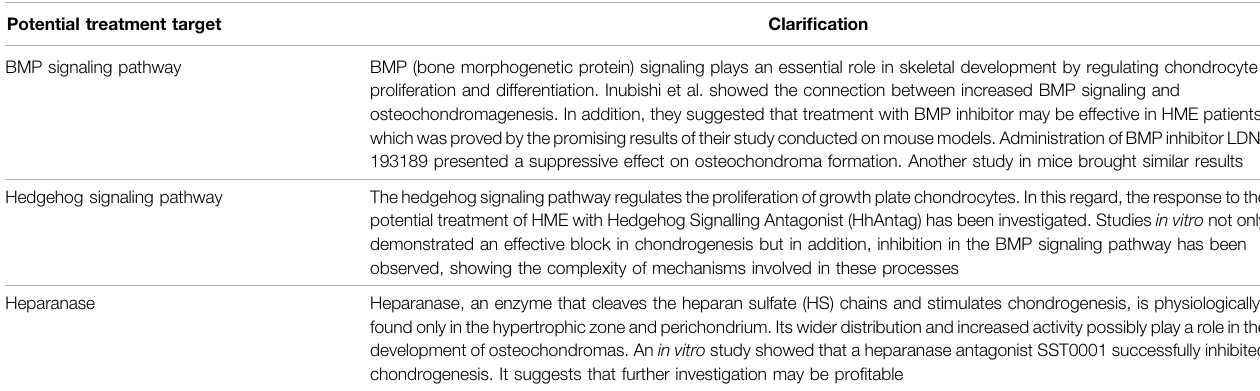
TABLE 3 | The presentation of potential treatment targets in hereditary multiple exostoses (HME) (Yoon et al., 2006; Bovée et al., 2010; Heuzé et al., 2014; Huegel et al., 2015; Mundy et al., 2016; Sinha et al., 2017; Inubushi et al., 2018; Paci fi ci,